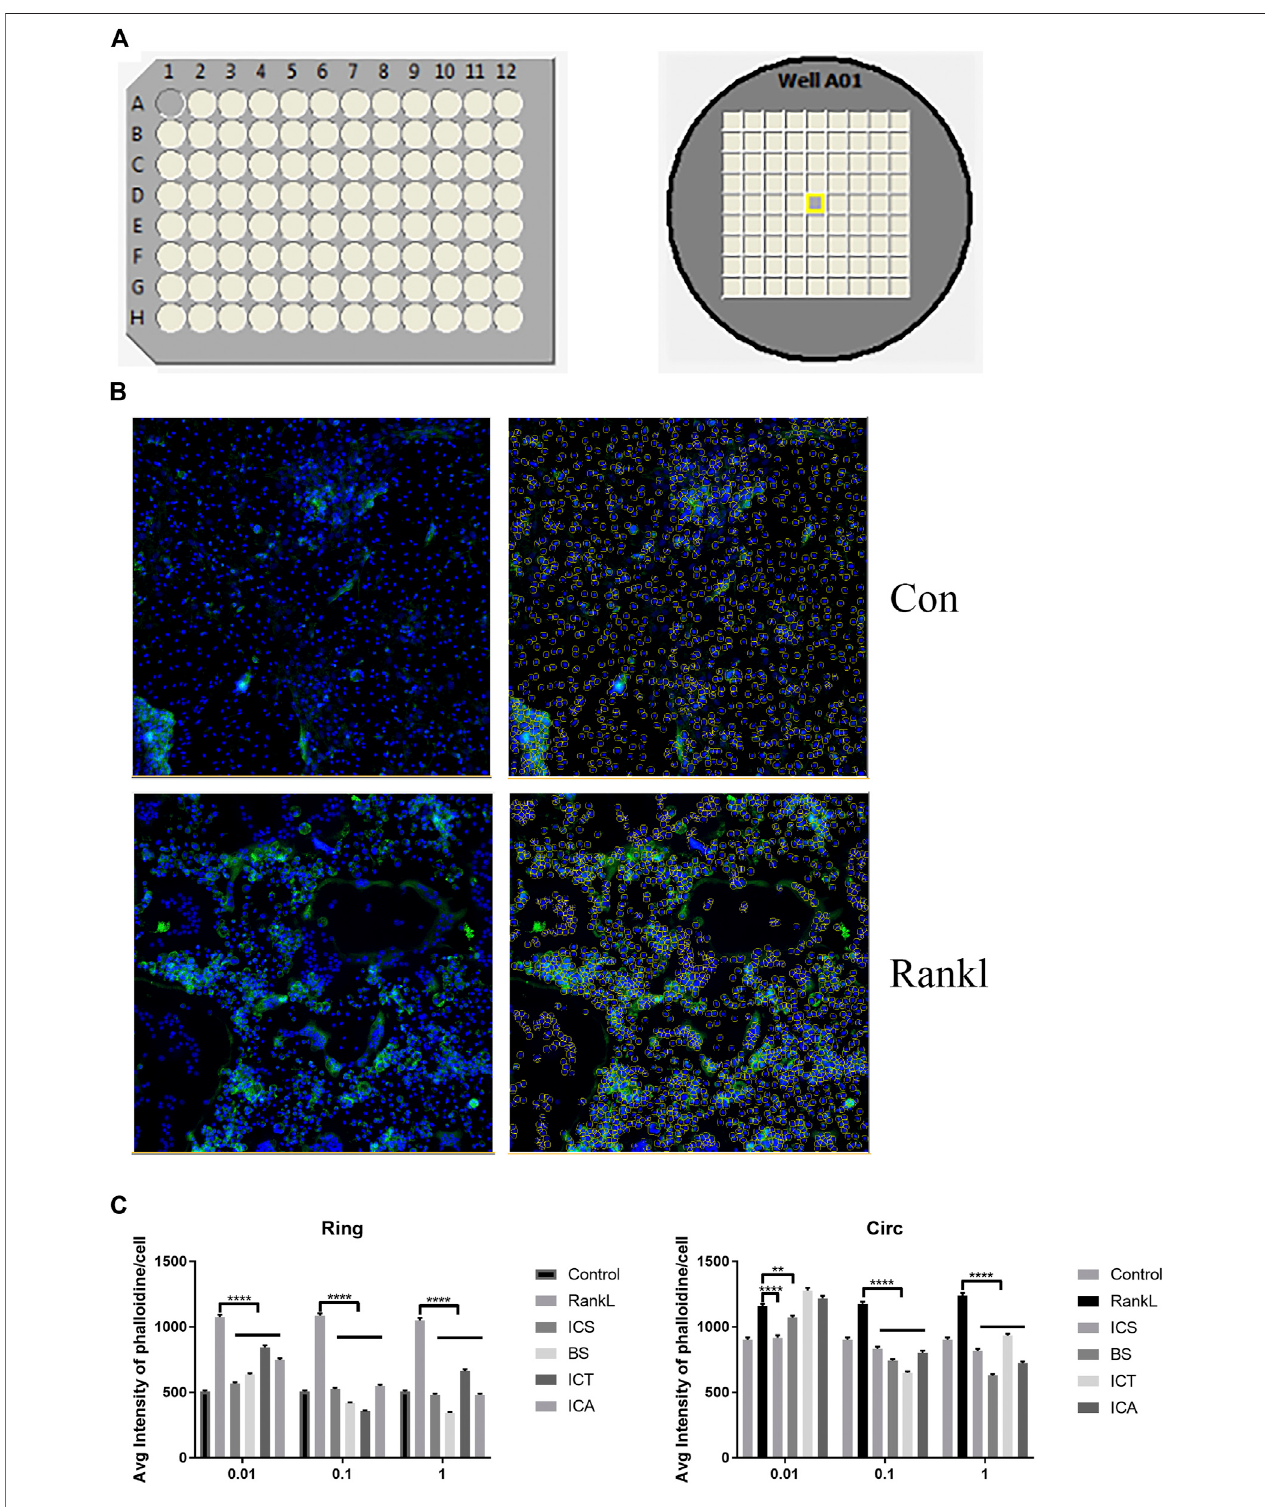
FIGURE 2 | High-content screening showing BS best inhibits F-actin formation. (A) The scheme of high-content screening protocol. The BMM cells were seeded onto 96-well plates until osteoclasts formation. (B) Representative quantitative analysis image of auto-segmentation based on nuclei identi fi cation. (C) The inhibition effect of different concentrations of ICA and its metabolites (0, 0.01, 0.1, and 1 µM) against RANKL-induced F-actin formation on BMMs were evaluated by the general intensity measurement assay. All bar graphs are presented as mean ± SEM; n = 3. ** p < 0.01, **** p < 0.0001.